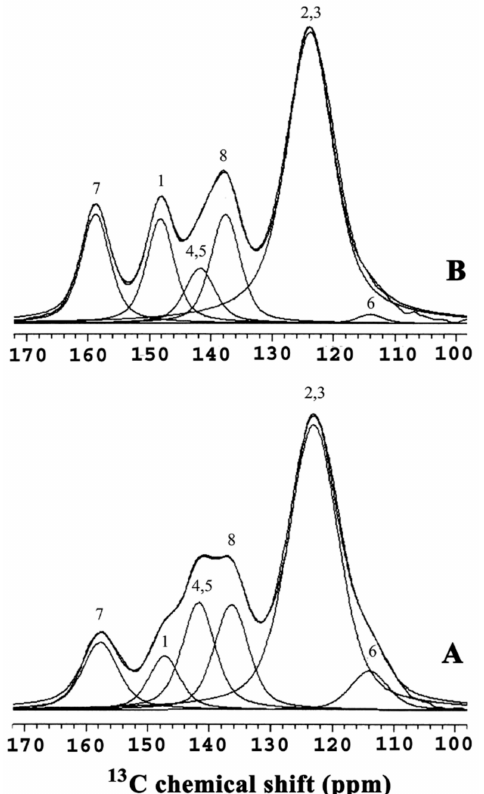
Figure 4. Deconvoluted 13 C CP / MAS spectra of PANI ( A ) and PANI–DPPH ( B ). Reprinted with permission from reference [28]. Copyright (2006)